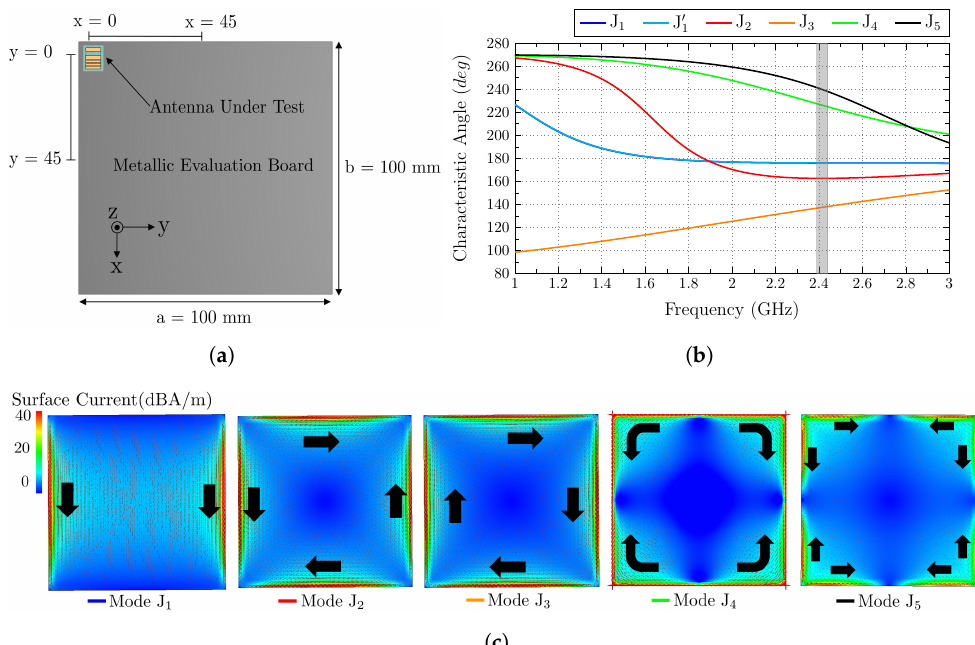
Figure 4. ( a ) Analyzed ground plane of 100 100 mm 2 with the antenna at four different positions, × ( b ) characteristic angles of the isolated ground plane modes (J 1 –J 5 ) with the operating frequency band colored in gray, and ( c ) current distribution of the isolated ground plane modes (J 1 –J 5 ). J (cid:48) is equivalent 1 to J 1 , but rotated 90 ◦ (degenerated mode). Black arrows describe the direction of the